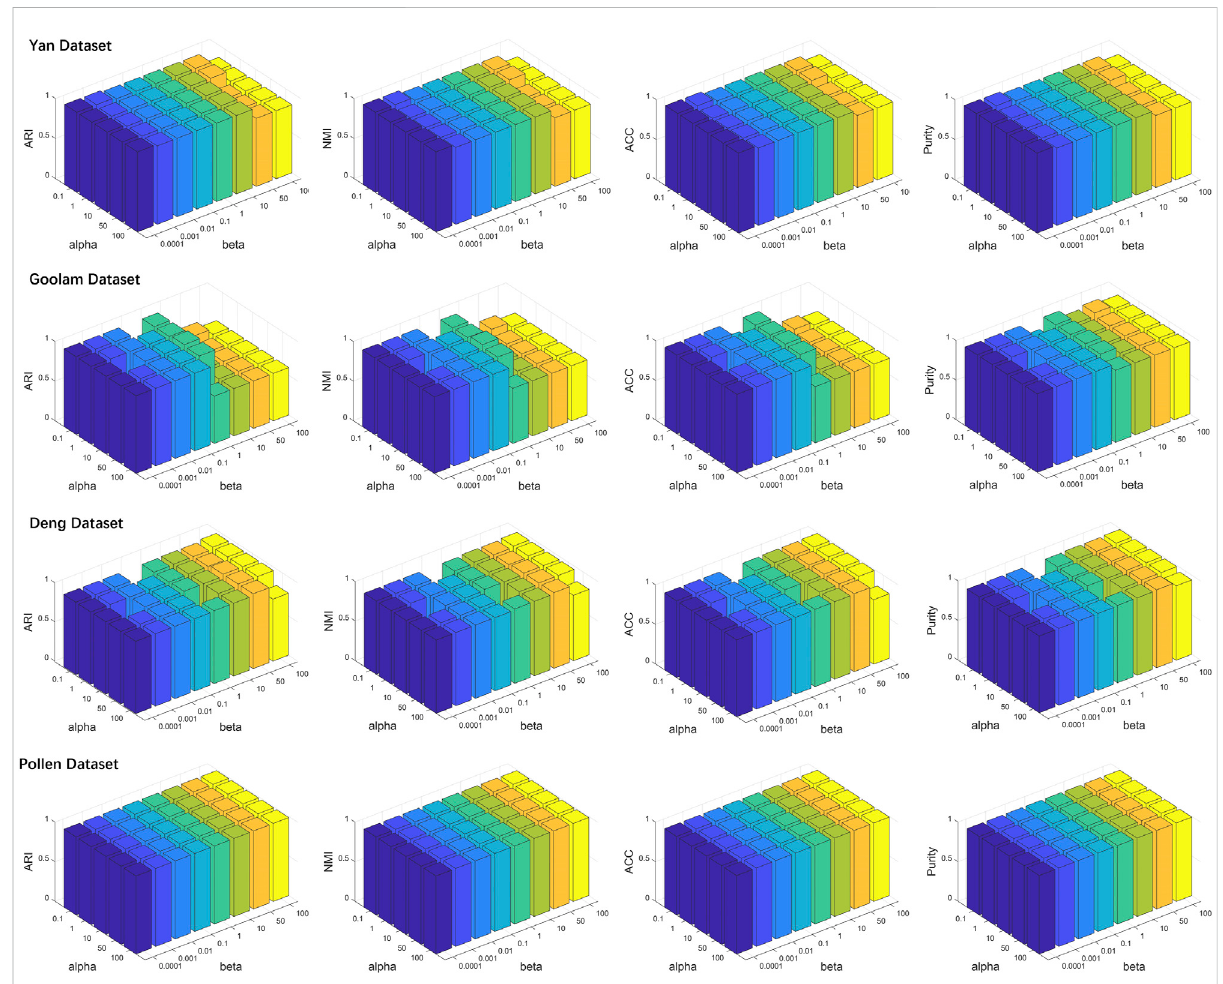
FIGURE 4 lustering evaluation (ARI, NMI, ACC, and purity) results of LFSC with different hyperparameters on four highly con fi dent scRNA-seq